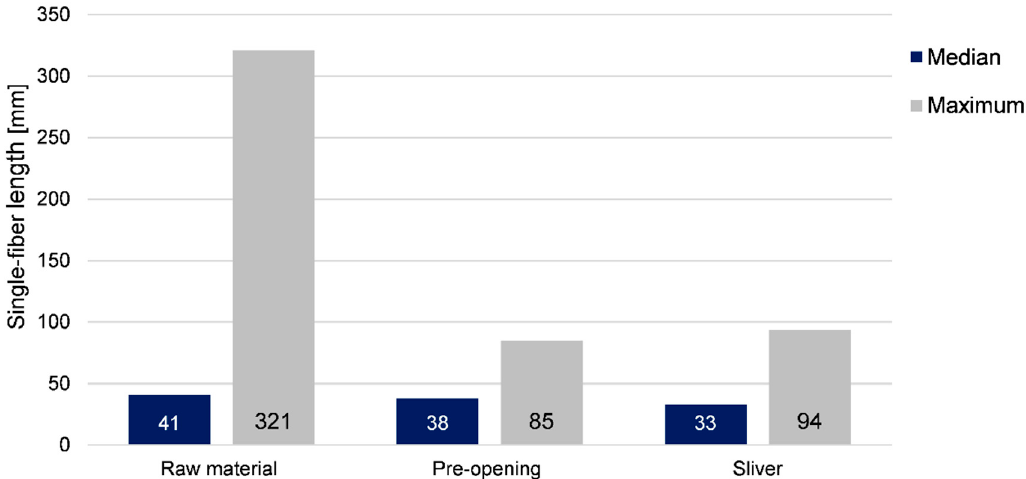
Figure 7. Change of the average and maximum carbon fiber length through the sliver production process.